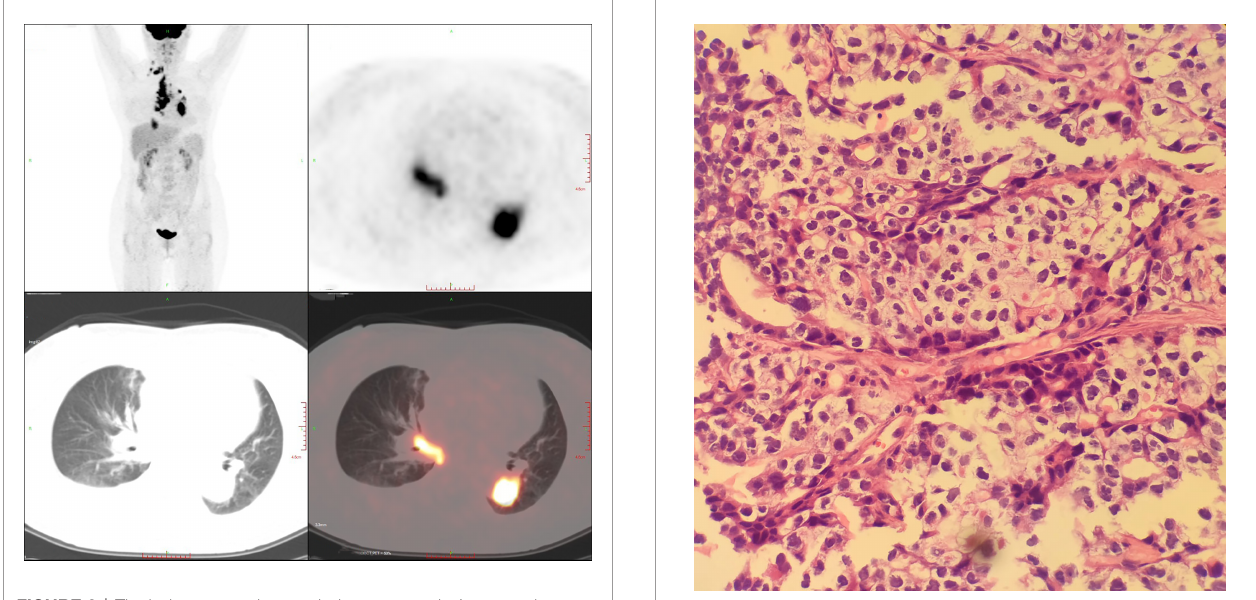
FIGURE 5 | Result of the second puncture: lung adenocarcinoma.